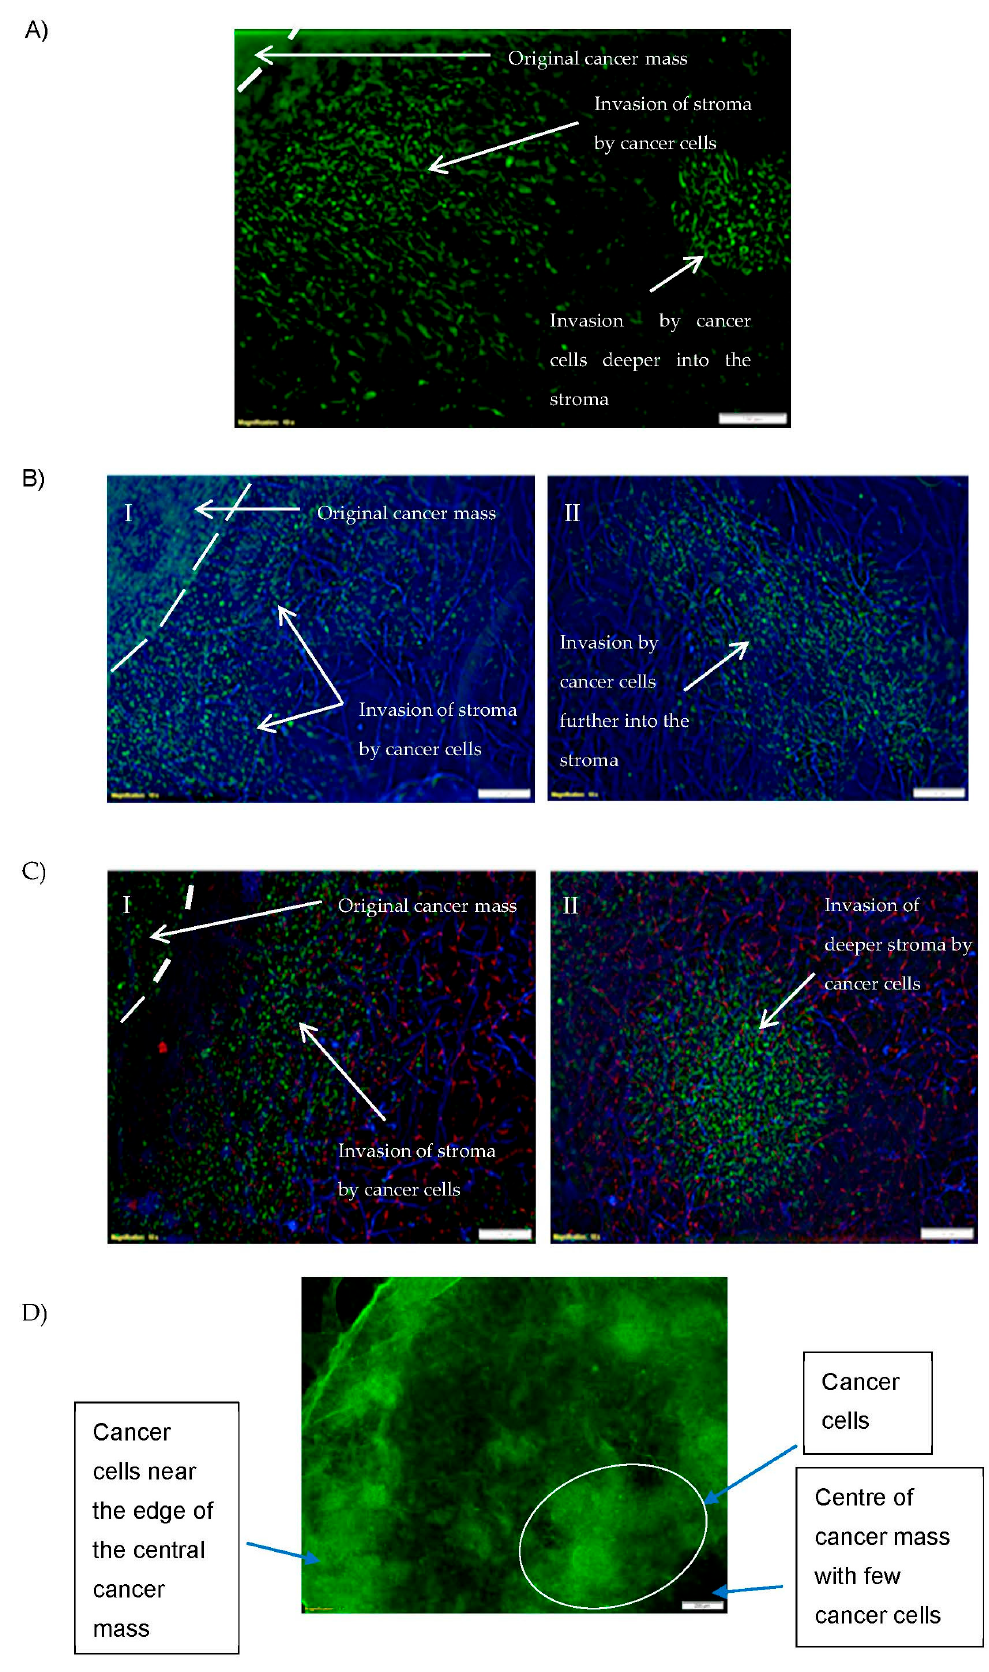
Figure 3. Cancer cell growth and stroma invasion by cancer cells in 3D ovarian tumouroids. ( A ) Invasion by cancer cells (HEY) from the original cancer mass into the adjacent stroma and deeper stroma